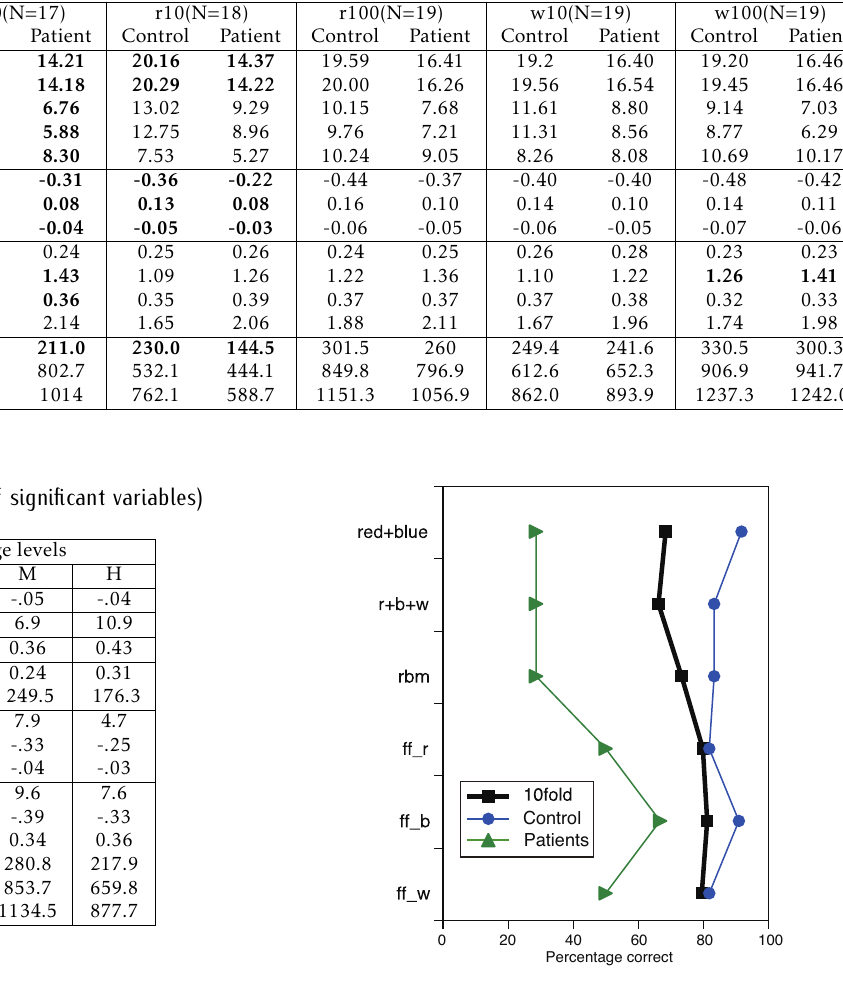
Figure 6. Comparison of classification